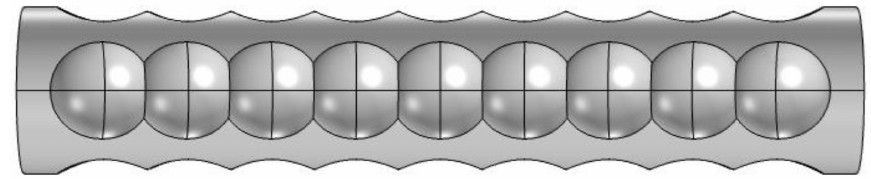
Figure 2. Capillary model with rough wall